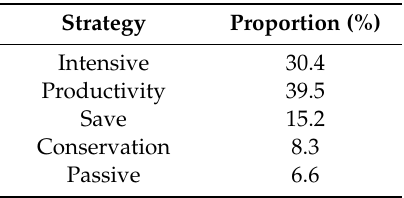
Table 4. Distribution of the five di ff erent forest owner strategies over the productive forestland ( >